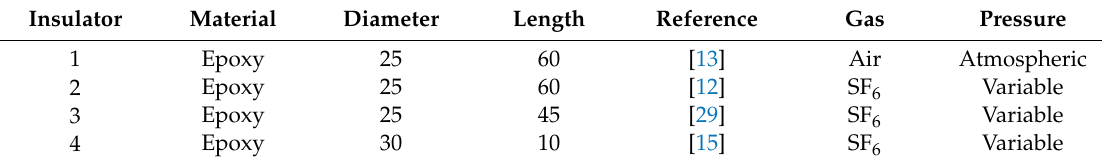
Table 1. Characteristics of used insulators from literature used in